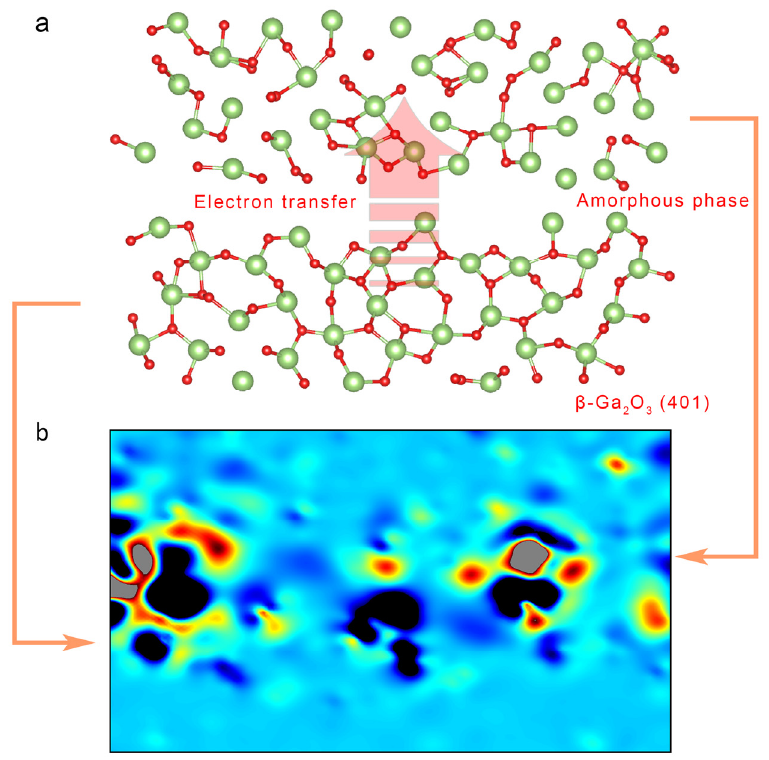
Figure 4. ( a ) Mixed phase of β -Ga 2 O 3 and amorphous structure. The pink arrow denotes the direction of charge transfer and the built-in electric field. ( b ) Charge density difference in the mixed phase. The red and blue areas signify the accumulation and depletion of electrons, respectively.